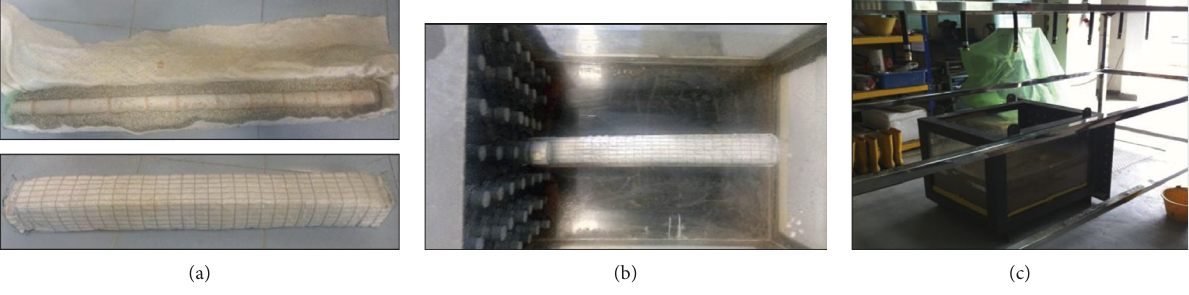
Figure 6: (a) Pipe in caging. (b) Setup of pipe in the model box. (c) Experimental setup (not to scale).